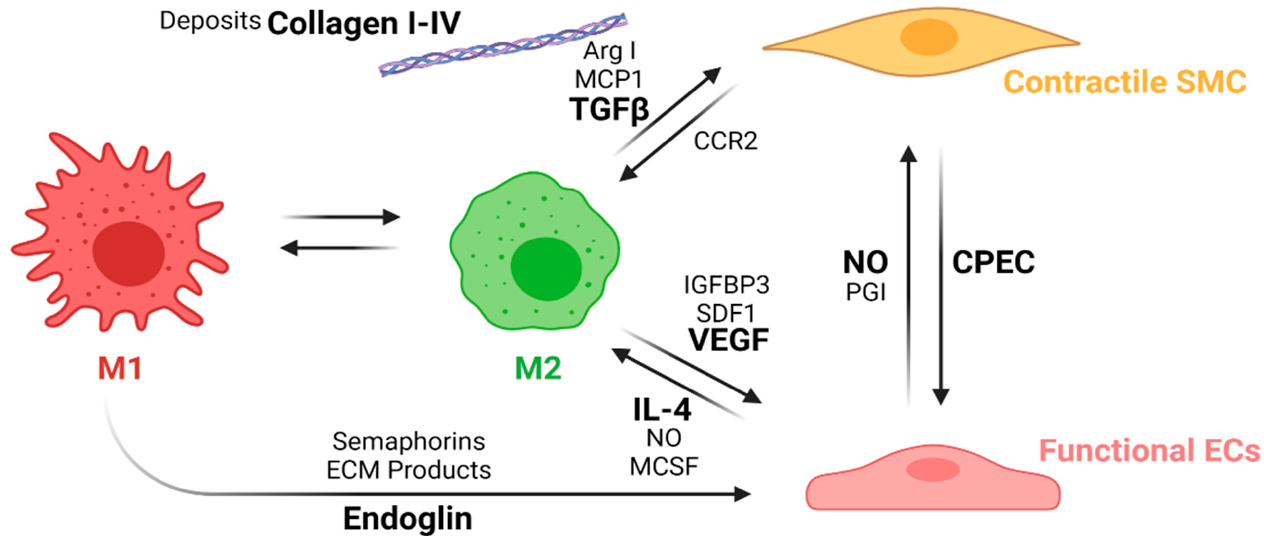
Figure 8. Macrophage polarization effects on the cell phenotypes in the regeneration process of the vascular wall. During the first weeks, M1 macrophages stimulates EC attachment and proliferation through the release of endoglins, semaphorins, and the ECM products during the phagocytosis. After the first weeks, inflammation resolution begins with macrophage populations switching towards an M2 phenotype due to the IL-4 and MCSF released by functional ECs as well as an increase in the NO levels produced by the ECs. M2 macrophages also induce vascular wall remodeling by increasing ECs recruitment and maturation through the release of VEGF, IGFBP3, and SDF1. M2 also induce the SMCs’ expression profile towards a contractile phenotype through the release of TGF β , ArgI, and MCP1, while contractile SMCs help the maintenance of the M2 population with the interaction of the CCR2. The interplay between mature ECs and contractile SMCs contributes to maintaining the vascular wall tone and patency (Created with BioRender.com, accessed on 7 November 2021).